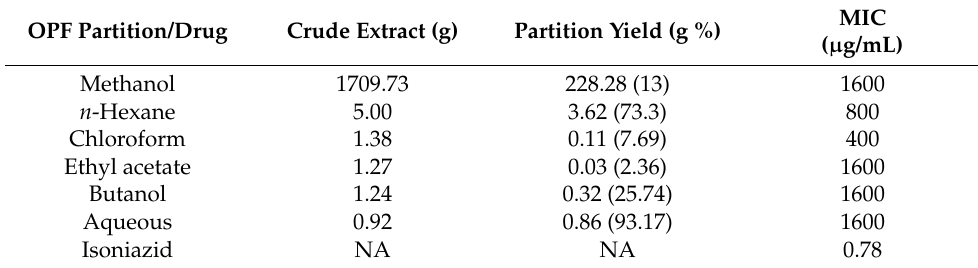
Table 1. Yield and in vitro anti-mycobacterial activity of oil palm fruit (OPF) mesocarp extract partitions against Mycobacterium tuberculosis (MTB)